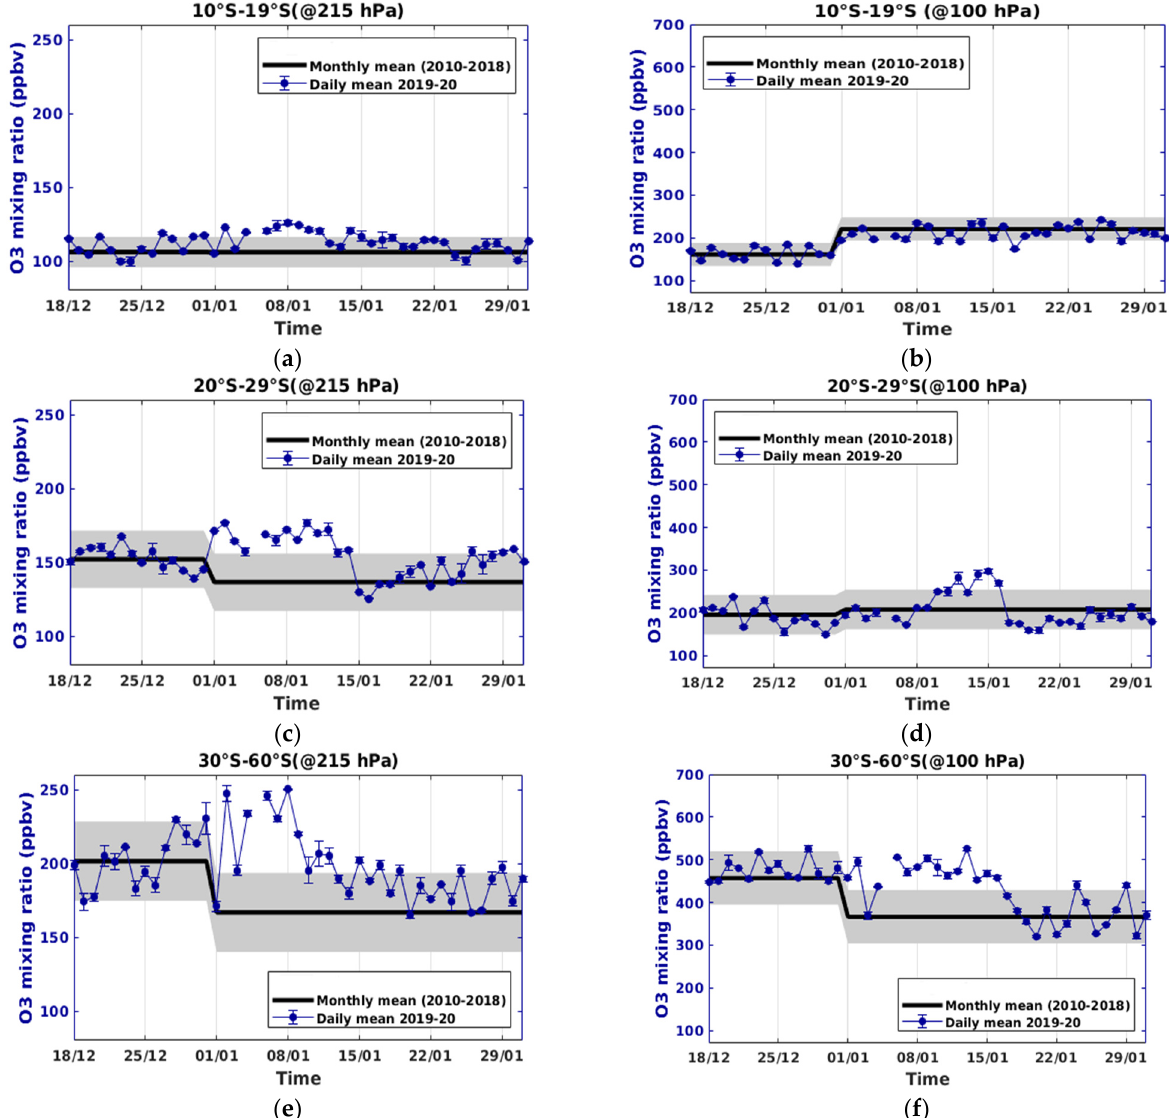
Figure 8. Daily mean evolution of the latitudinal mean of OMR (blue lines) obtained from MLS at 215 hPa ( a , c , e ) and 100 hPa ( b , d , f ) between 18 December and 31 January 2020 over Oceania (black box in Figure 7b). The OMR mean values are calculated over tropical (top, 10°S–19°S), subtropical (middle, 20°S–29°S) and extratropical (bottom, 30°S–60°S) latitudinal bands. The monthly mean and the associated standard deviation calculated over the 2010–2018 period are in black lines and grey areas, respectively.